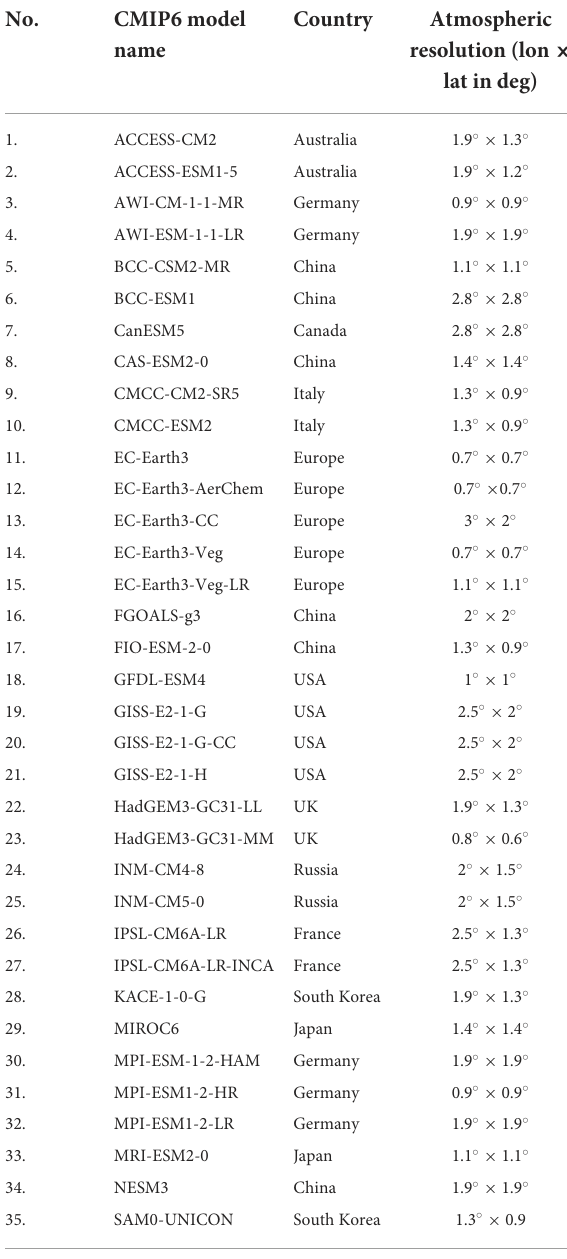
TABLE 1 List of CMIP6 historical global climate models used in this